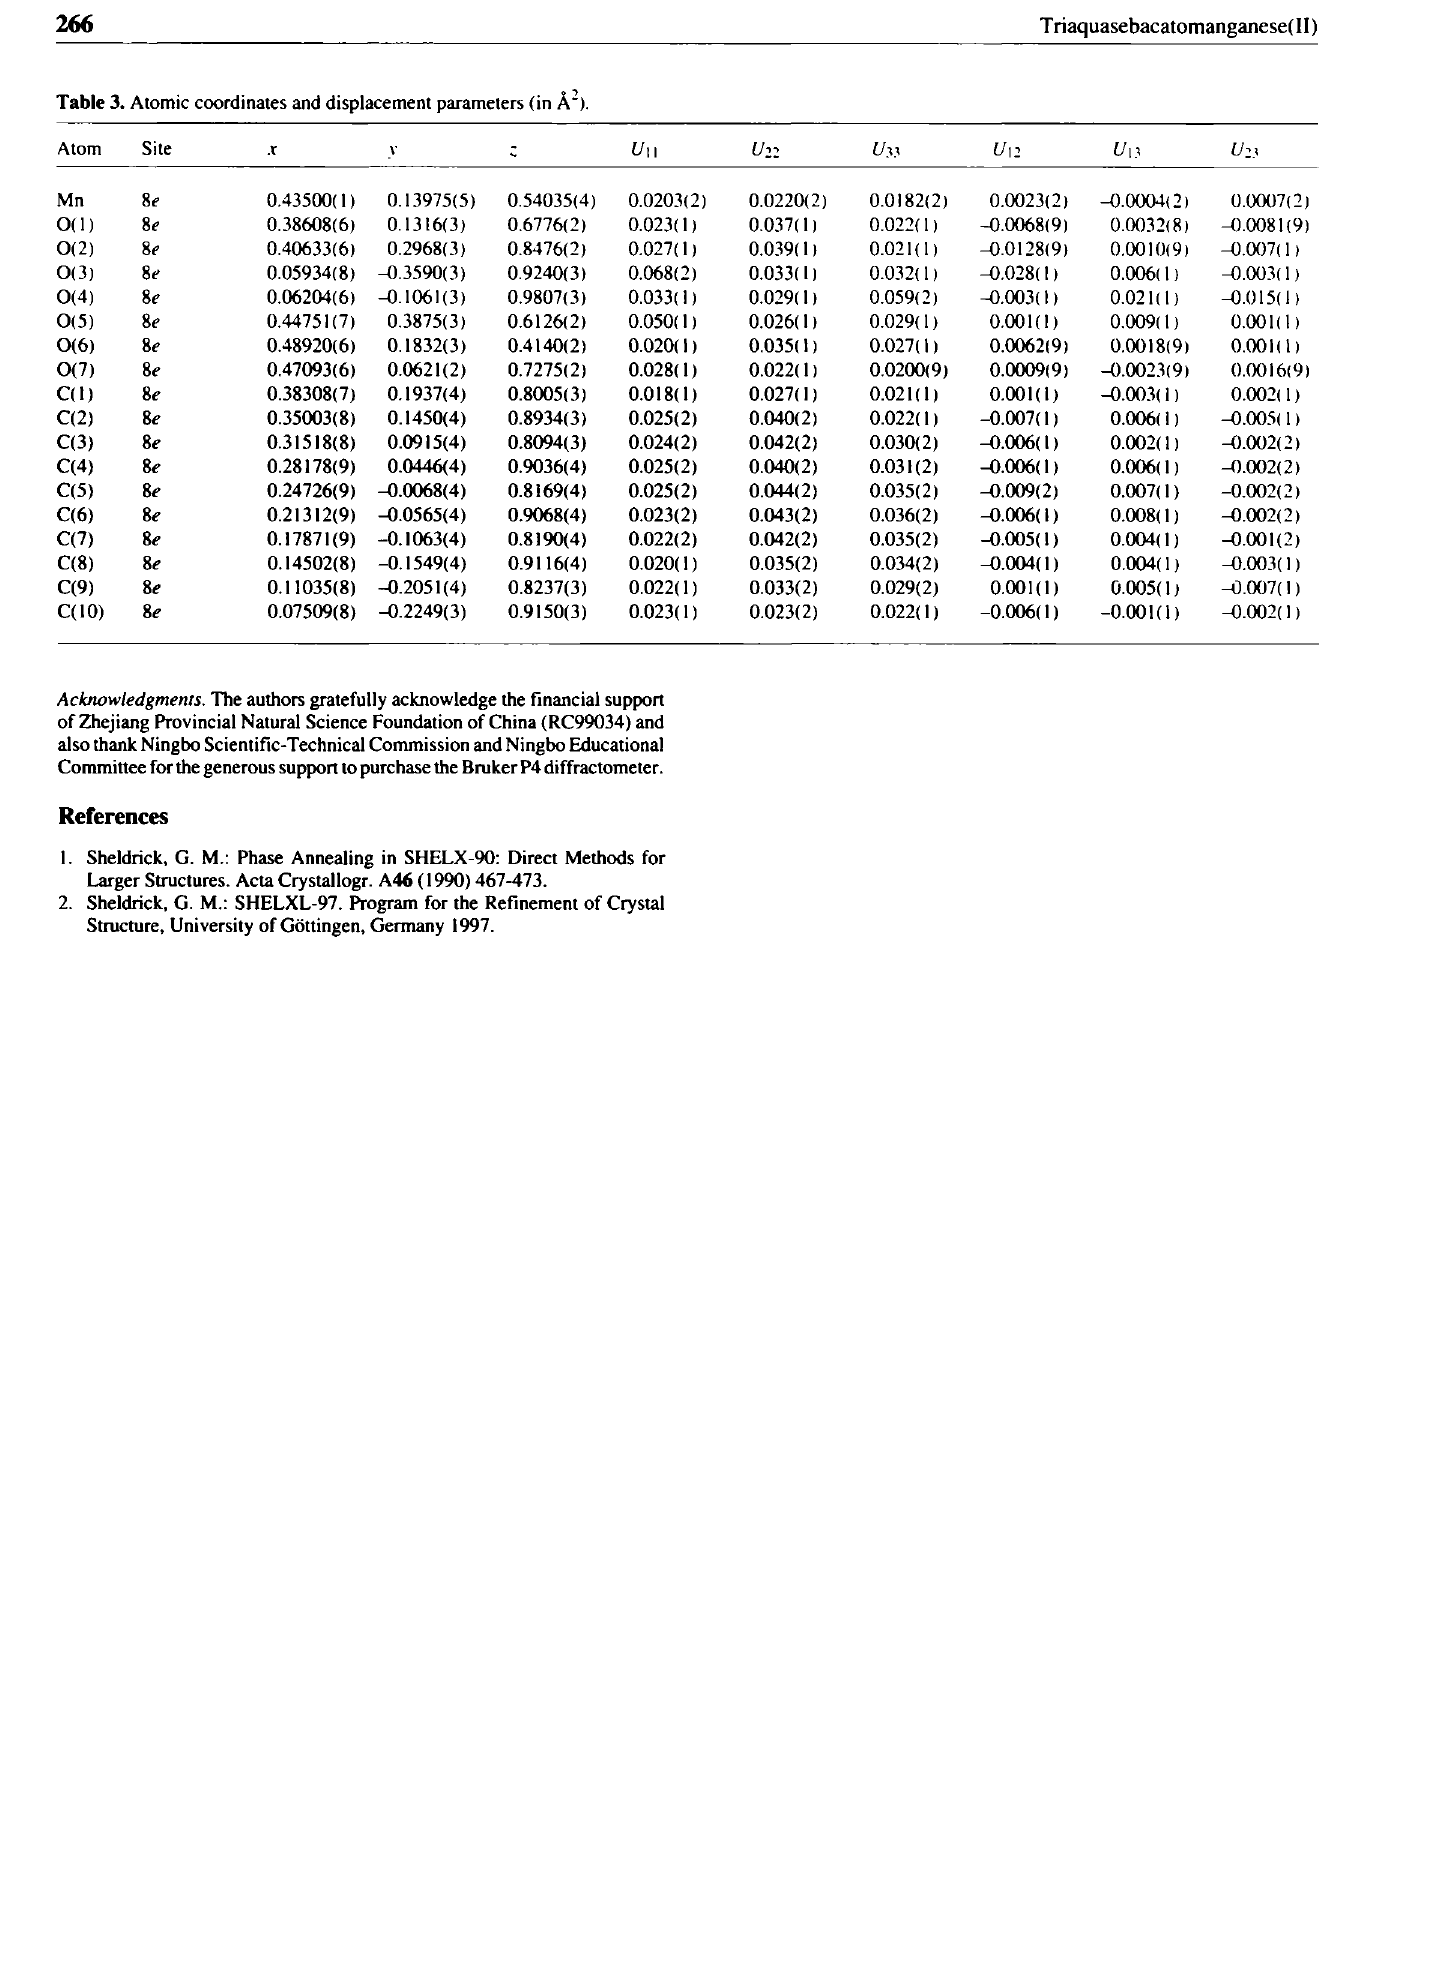
Table 3. Atomic coordinates and displacement parameters (in